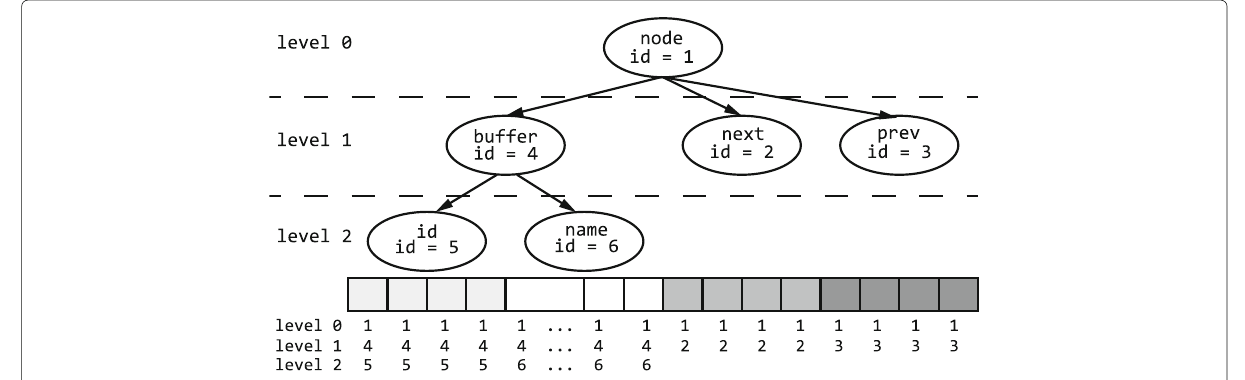
Fig. 9 The MRR tree and memory range after